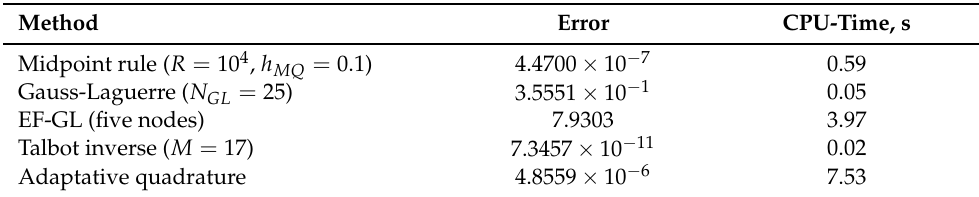
Table 1. Comparison of various numerical methods for problem (25) with a = 2, b = 1 and c = 3 (Example